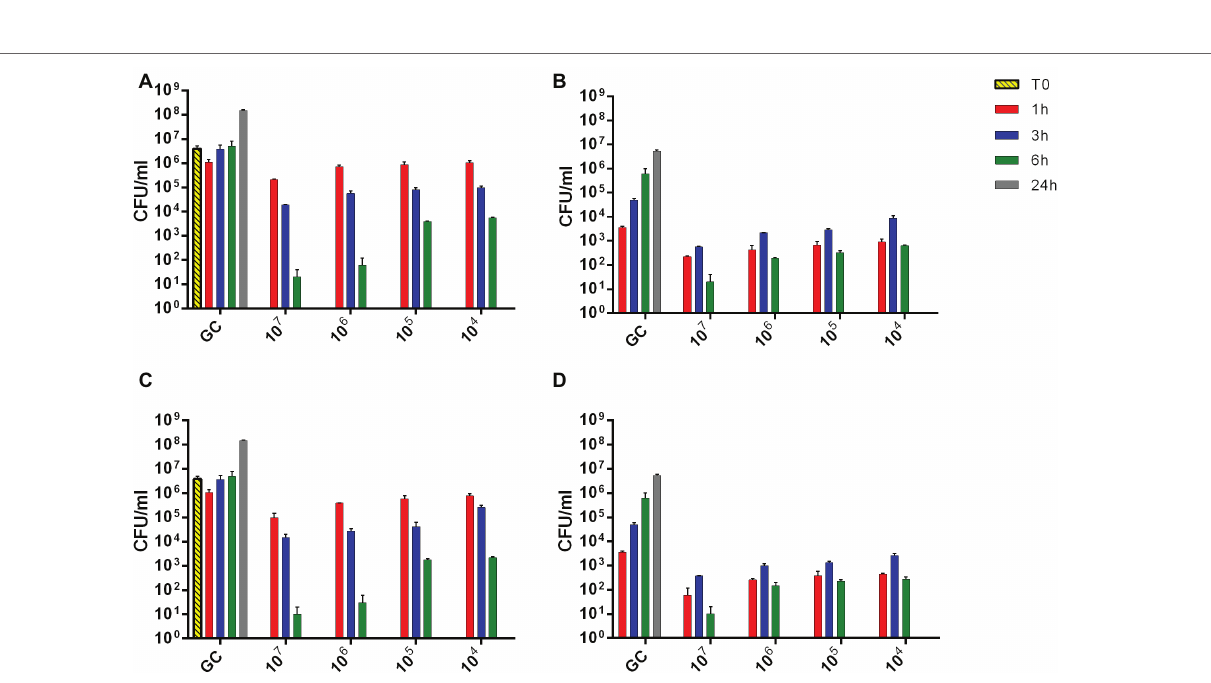
FIGURE 9 | CLSM analysis of biofilm of MRSA ATCC 43300 preventively incubated with either Sb or PYO. The viability of the cells attached on the surface was evaluated after 24 h incubation staining with green fluorescent labeled SYTO9 (488/500–540 nm) for alive bacteria and with red fluorescent propidium iodide (PI) (561/600–650 nm) for dead bacteria. Images are merged from the two channels. Upper and lower panels represent xy- and z-plans, respectively. Scale bar: 25 μ m.